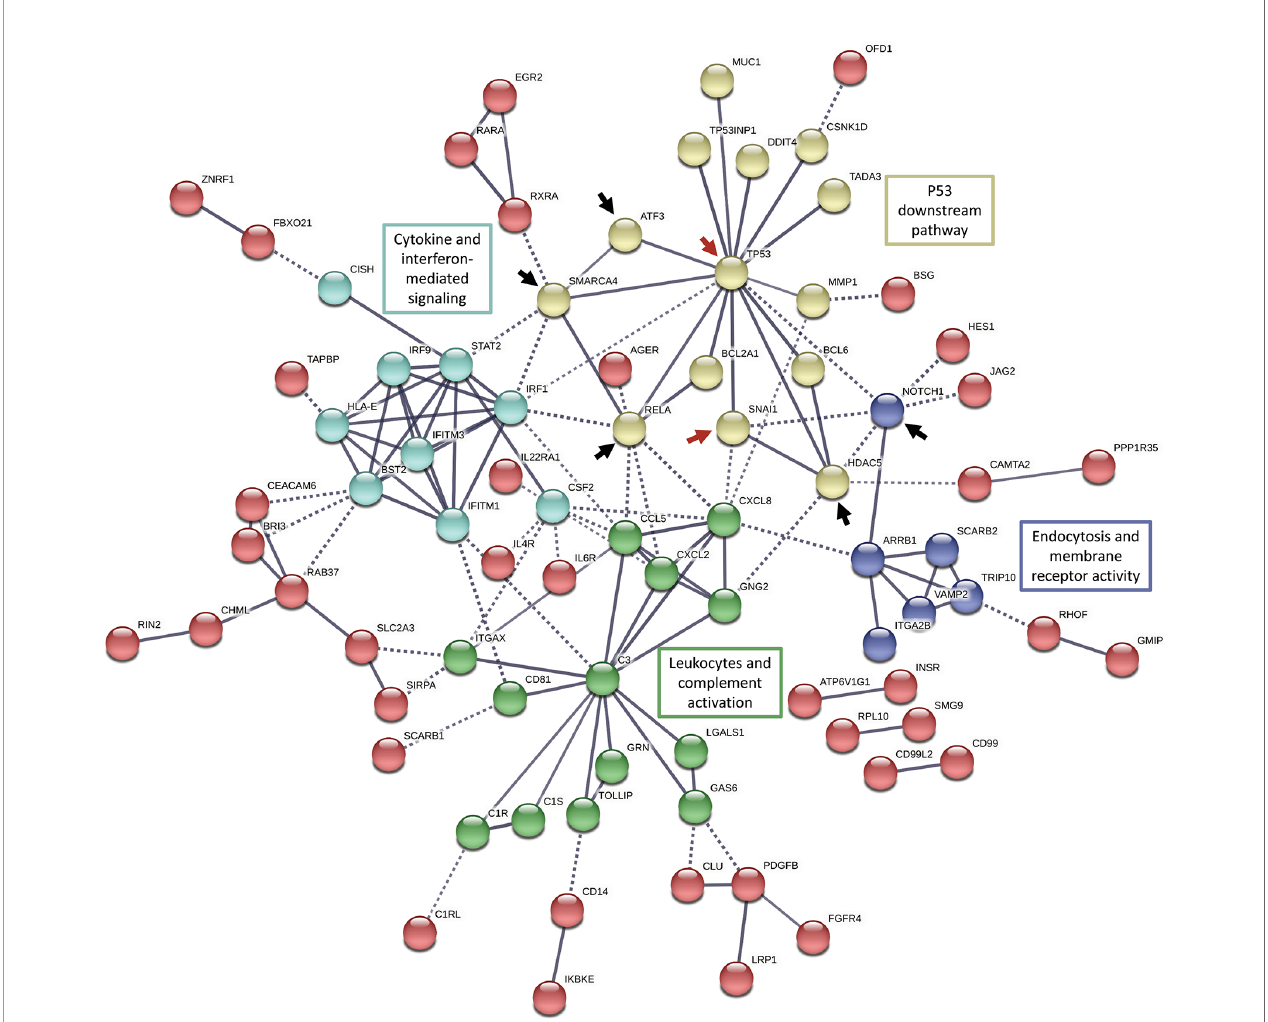
FIGURE 4 | String functional protein association networks analysis in all the differentially expressed genes (FC >2 or <0.5) enriched in the immune gene ontology sets. Red arrows indicate elements of our target molecules, p53 and Snail; black arrows indicate potential regulatory nodes induced by Snail-p53 binding to modulate immune response